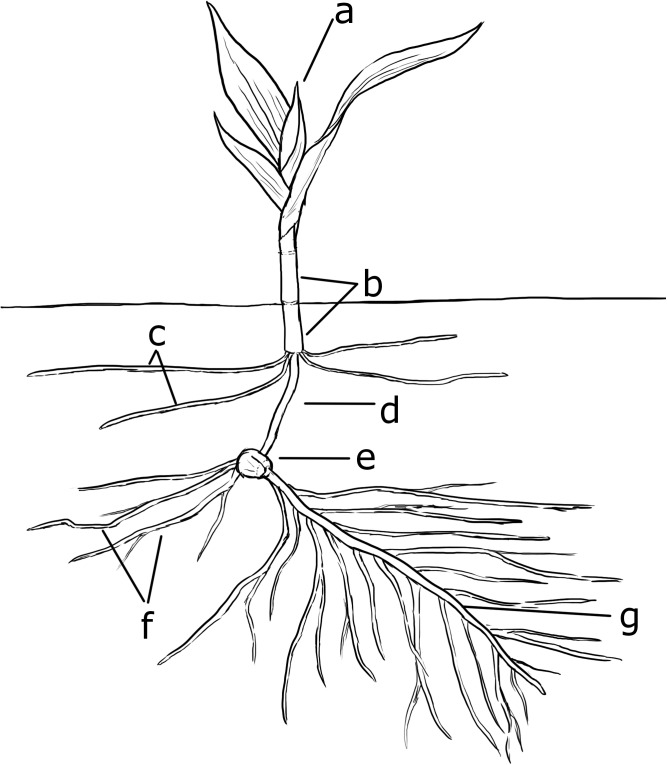
Diagram of a maize seedling at the soil surface interface, showing (a) Stem apex, (b) coleoptile, (c) nodal roots, (d) mesocotyl, (e) seed, (f) seminal roots, and (g) radicle roots. For homogenization purposes, the shoot region was classified as sections (a-d), the seed region as (e), and the root region as (f) and (g).